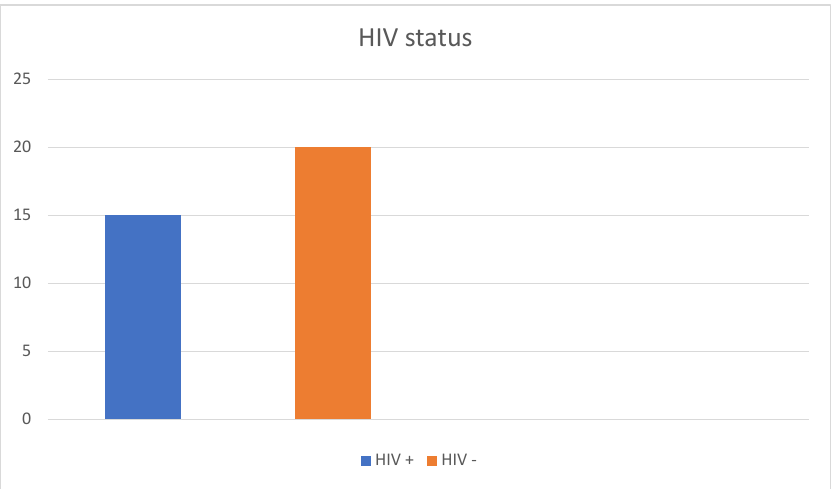
Figure 3. Distribution of the patients in our study based on sex. The vast majority being male (91.4%), 37% of which were MSM. Figure 4. Prevalence of HIV in our patient cohort. Nearly half (42.8%) of the patients were HIV positive.